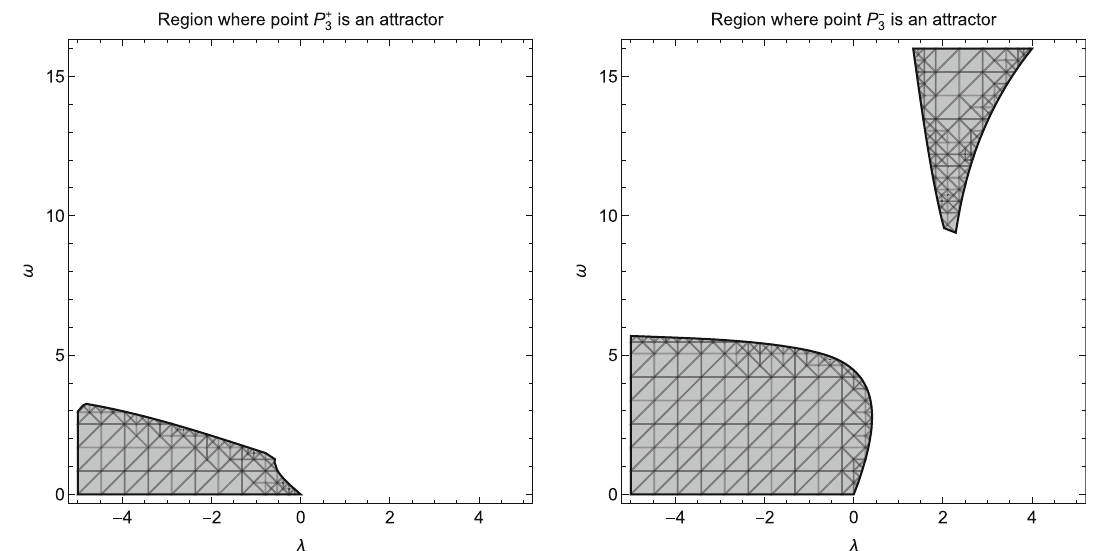
Fig. 1 Region plot in the space (λ,ω) the stationary points P ±